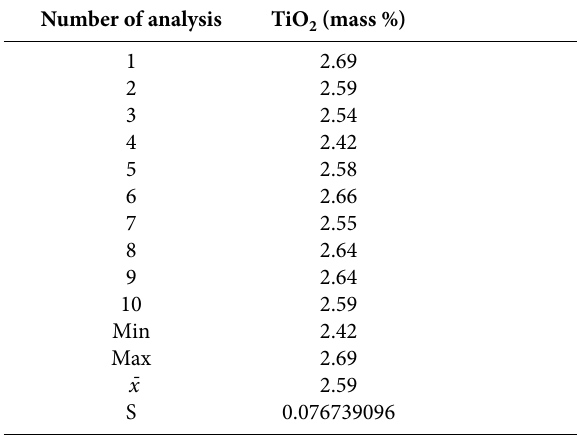
Table 7. The content of TiO 2 in ten different samples of “Grčka” bauxite calculated using spectrophotometric method JUS